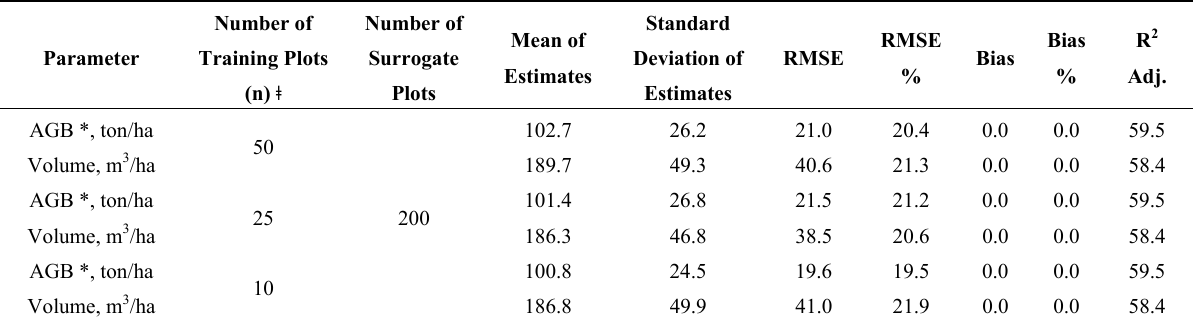
Table 6. Accuracy of RapidEye prediction against ALS estimation at phase